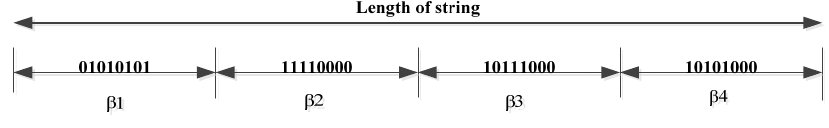
Figure 4. Length of string with codes.